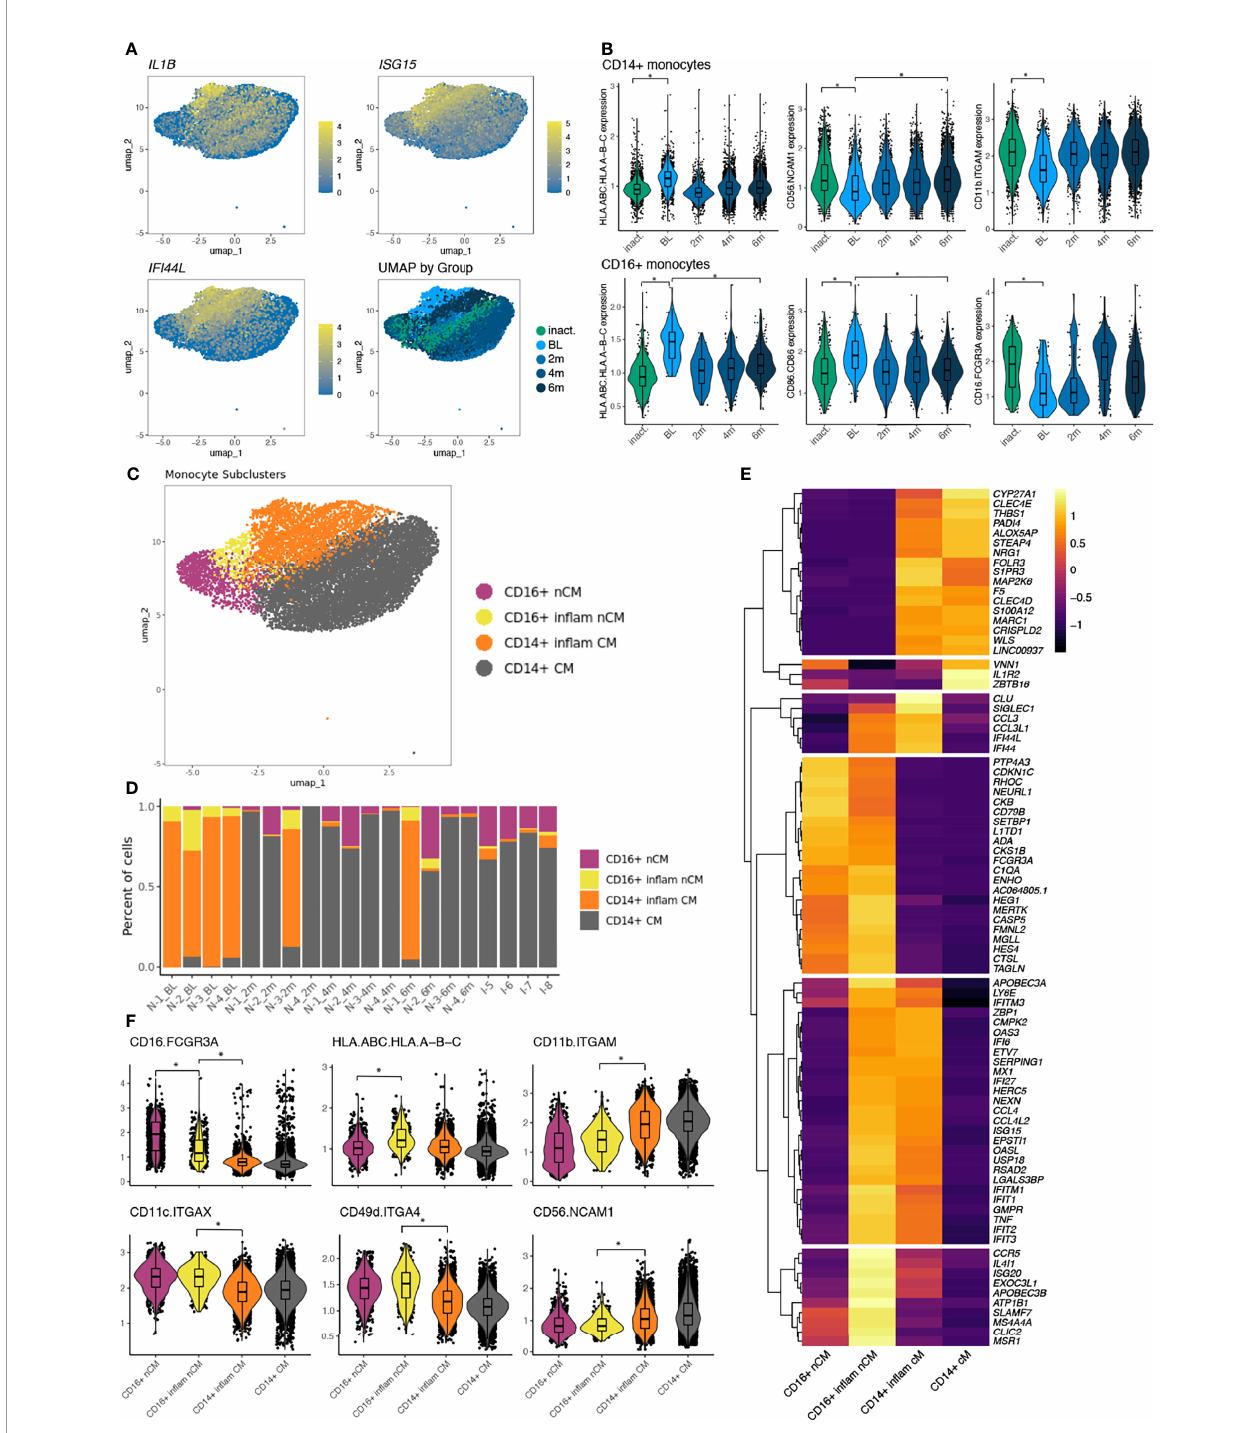
FIGURE 4 | (A) UMAP plots of the monocyte population colored by select features where color represents the log-normalized expression. The fourth panel is colored by disease group. (B) The normalized expression of differentially expressed protein markers in baseline (BL) samples compared to inactive (inact.) samples as well as to 6 month (6m) samples. Signi fi cance is indicated by a log-fold change >0.5 and FDR<0.05 indicated by *. (C) UMAP of monocyte populations colored by monocyte cell states following a second round of clustering of CD16 + nCM. (D) The proportion of cells making up the monocyte subclusters per sample ordered by time and disease group. (E) A heatmap displaying differentially expressed transcripts between monocyte populations using a log-fold change >3 and adjusted p- value <0.05. All genes differentially expressed meeting signi fi cance thresholds are displayed in Supplementary Table 3 . (F) Violin plots displaying expression values of differentially expressed proteins between monocyte subsets using a log-fold change >0.5 and adjusted p-value <0.05 indicated by